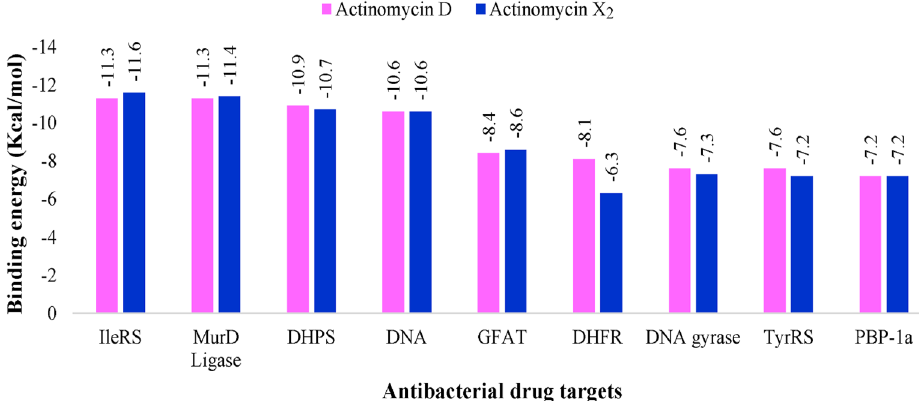
Figure 9. The plot of molecular docking predicted binding energy (Kcal/mol) and several antibacterial drug targets. IleRS isoleucyl-tRNA synthetase, MurD UDP-N-acetylmuramoyl-L-alanine:D-glutamate, DHPS dihydropteroate synthase, DNA deoxyribonucleic acid, GFAT glucosamine-fructose-6-phosphate aminotransferase, DHFR dihydrofolate reductase, TyrRS tyrosyl-tRNA synthetase, PBP-1a penicillin-binding protein